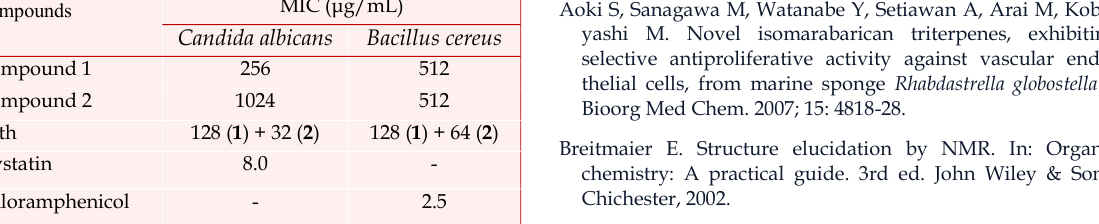
Antimicrobial activity of the isolated compounds